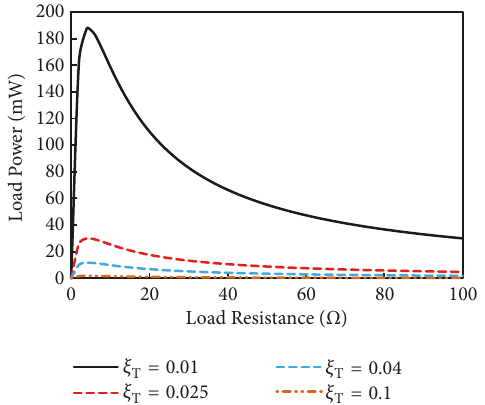
Figure 11: Load power as a function of load resistance produced for the simulated energy harvester.